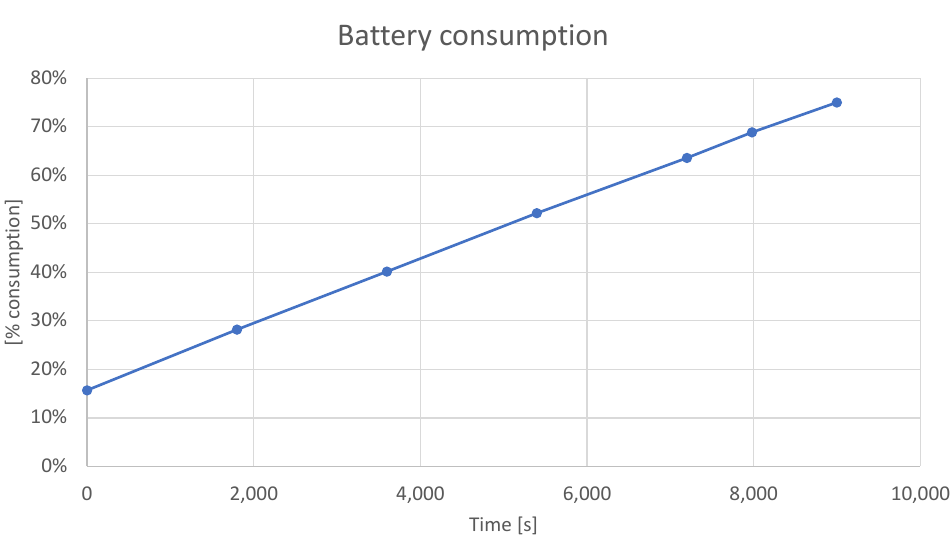
Figure 11. Schematic representation of the performance of the batteries consumption. The consump- tion level shows a linear dependency to the elapsing